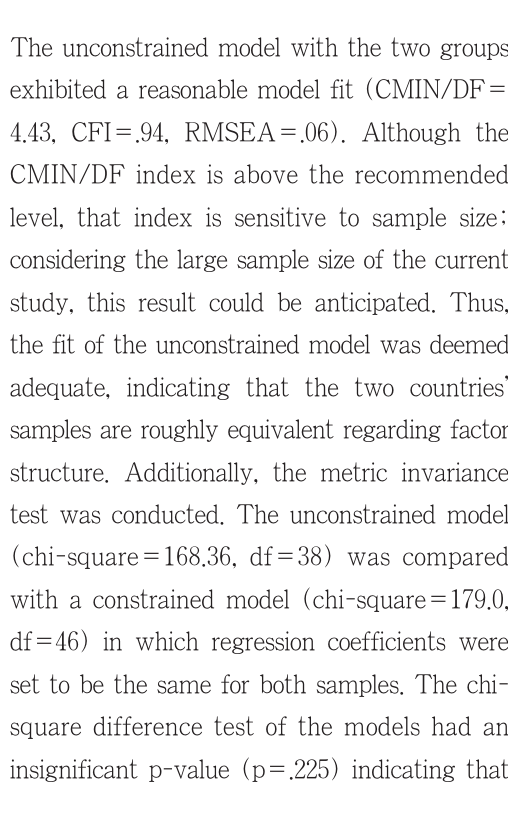
<Figure 1> CFA Model for Measurement Invariance Test across